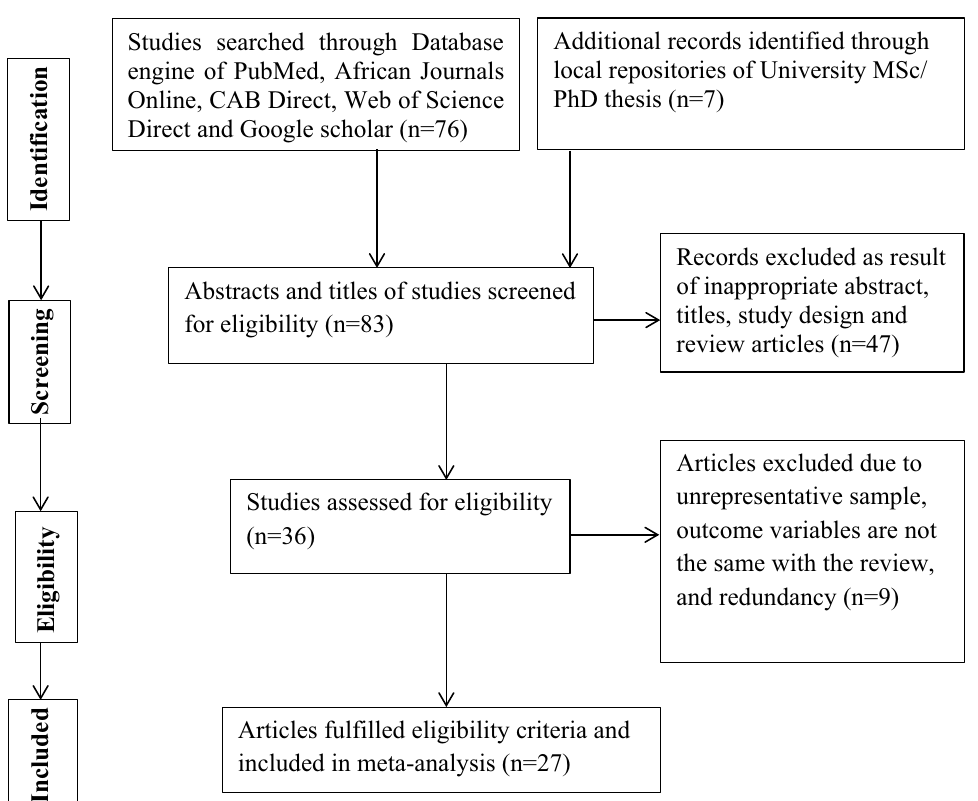
Fig. 1 Schematic representation of literature selection procedure adopted for the systematic review of Foot and Mouth Disease prevalence in Ethiopia. This Flowchart shows the literature search and inclusion/exclusion